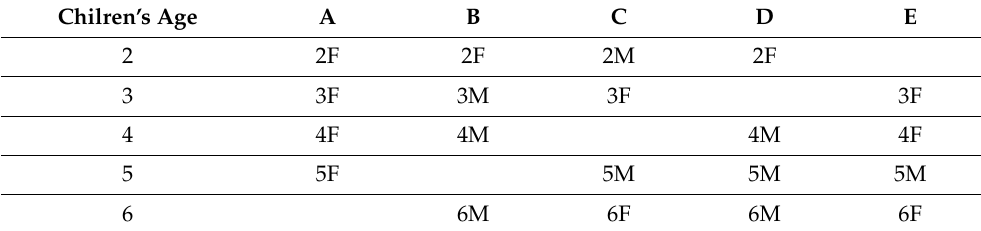
Table 2. Listener groups (A to E) and the age and gender of children in each group (M for male, and F for